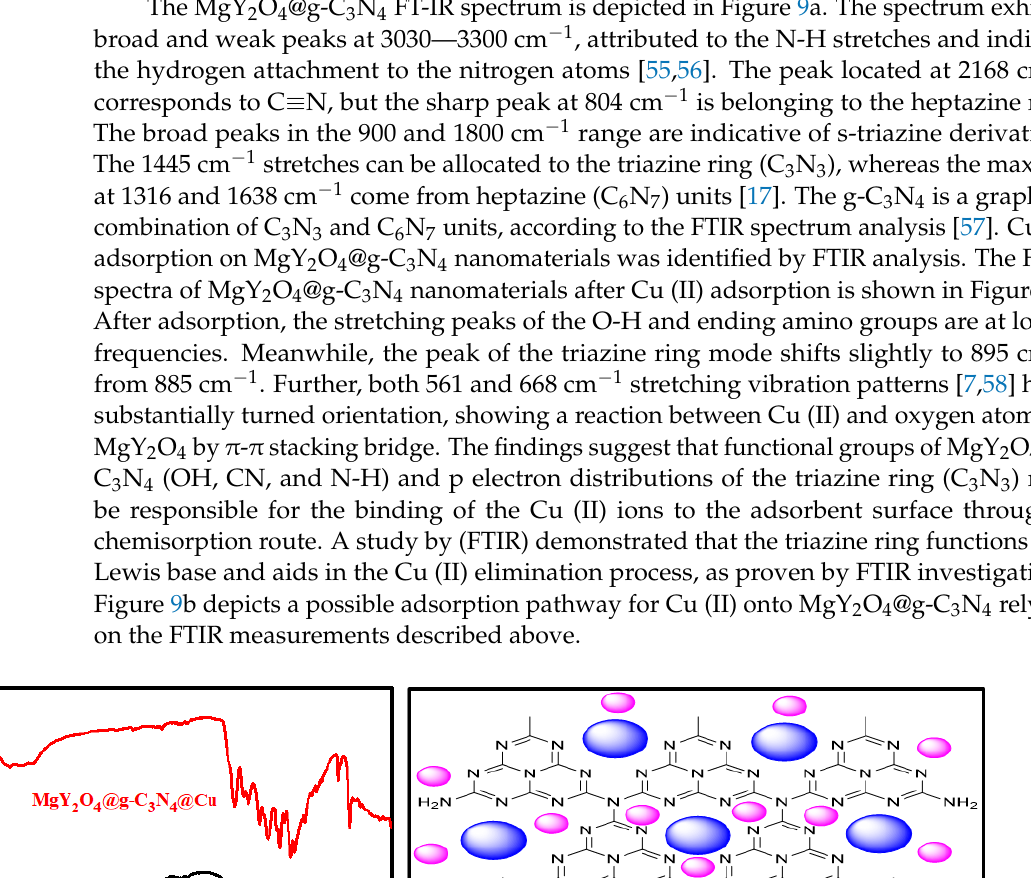
Table 3. Comparison of MgY 2 O 4 @g-C 3 N 4 adsorption parameters with various adsorbents.